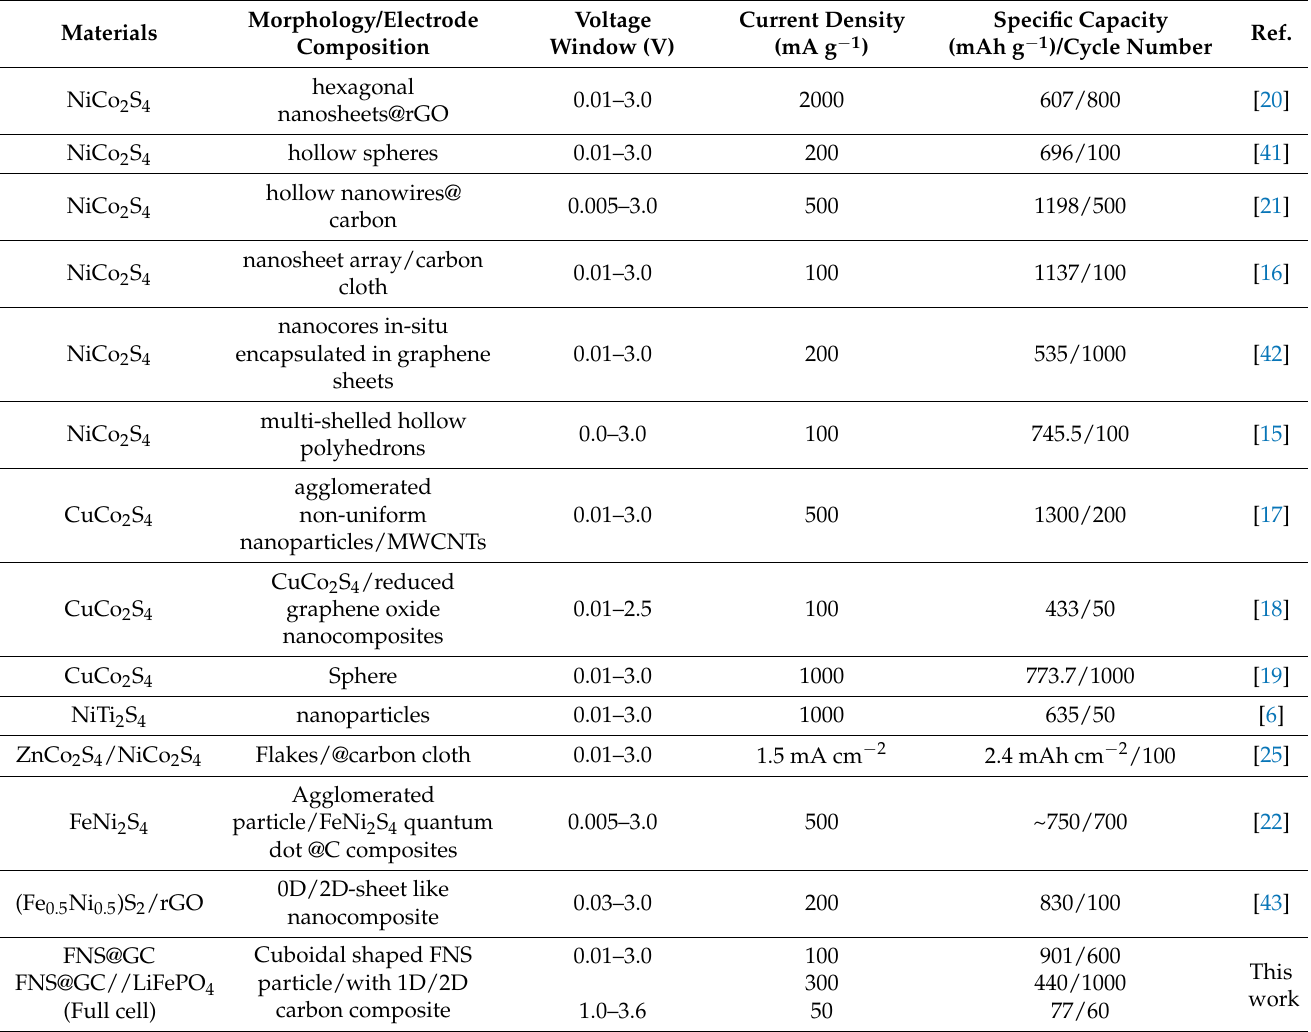
Table 1. Comparison of Ternary metal sulfides as LIB anode